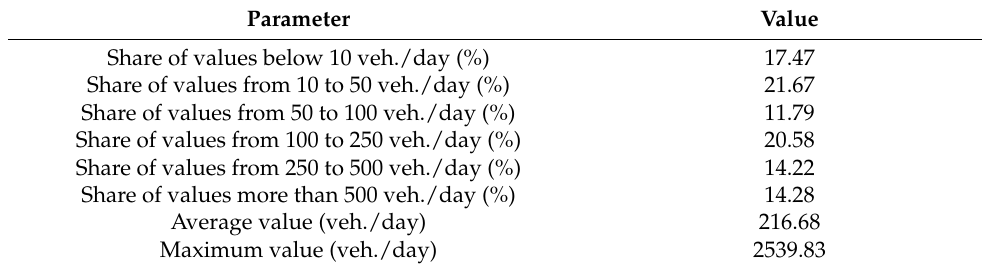
Table 4. The structure of the sample of traffic flows generated jointly by domestic and foreign trips.